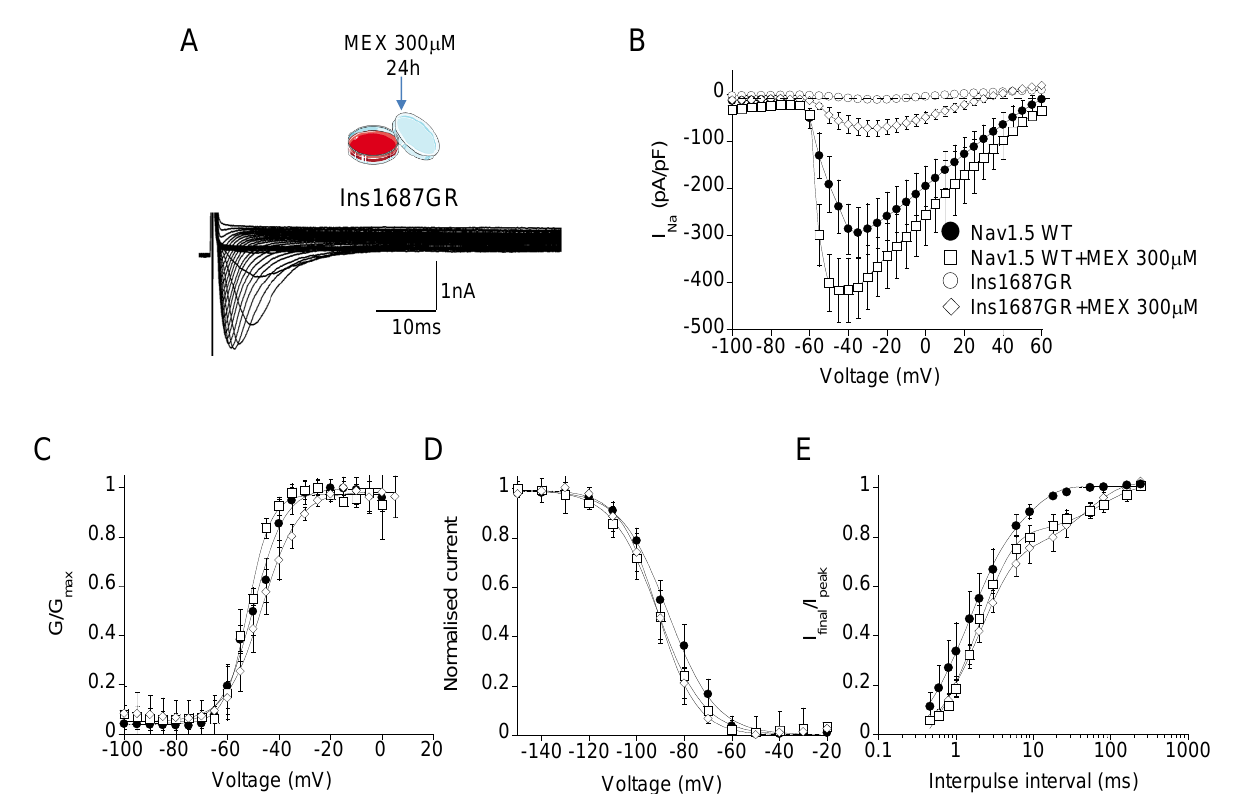
Figure 8. Effect of 24h incubation with 300 µ M mexiletine on Nav1.5 WT and Ins1687GR channels. ( A ) Representative sodium current traces from cells expressing Nav1.5 WT and Ins1687GR channels in control solution and after 24 h incubation with 300 µ M mexiletine. Mexiletine, was washed out prior to recording sodium currents. ( B ) IV plot showing the mean current density of Nav1.5 WT and Ins1687GR channels as a function of membrane potential before and after 300 µ M mexiletine incubation. ( C ) Voltage-dependence of activation for Nav1.5 WT and Ins1687GR channels in control solution and after 300 µ M mexiletine incubation. ( D ) Voltage-dependence of fast inactivation for Nav1.5 WT and Ins1687GR channels in control solution and after 300 µ M mexiletine incubation. ( E ) Recovery from fast inactivation for Nav1.5 WT and Ins1687GR channels before and after 300 μ M mexiletine incubation. Data are mean ± SE; n = 6 – 8 cells. Table 2. Current density and biophysical parameters of Nav1.5 WT and BrS mutant Ins1687GR channels expressed in HEK 293 cells after 24h incubation with mexiletine 300 μ M.